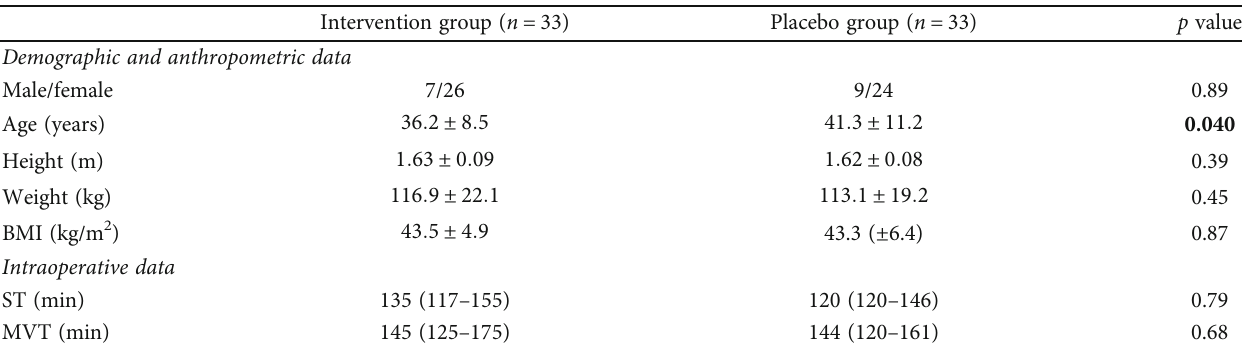
Table 1: Demographic and anthropometric data, pulmonary function data, pain scale scores, and haemodynamic data in the preoperative period and variables measured in the intraoperative period.